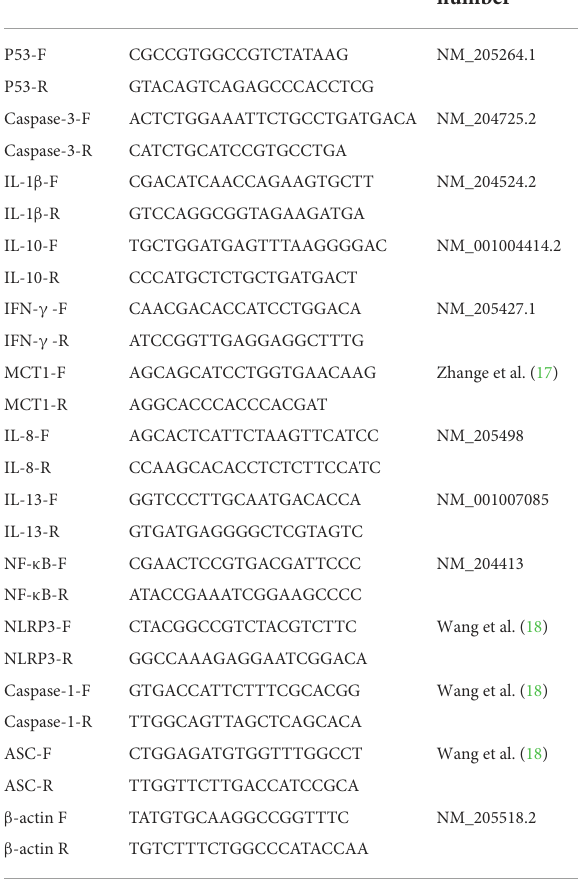
TABLE 2 Sequences of oligonucleotide primers used for